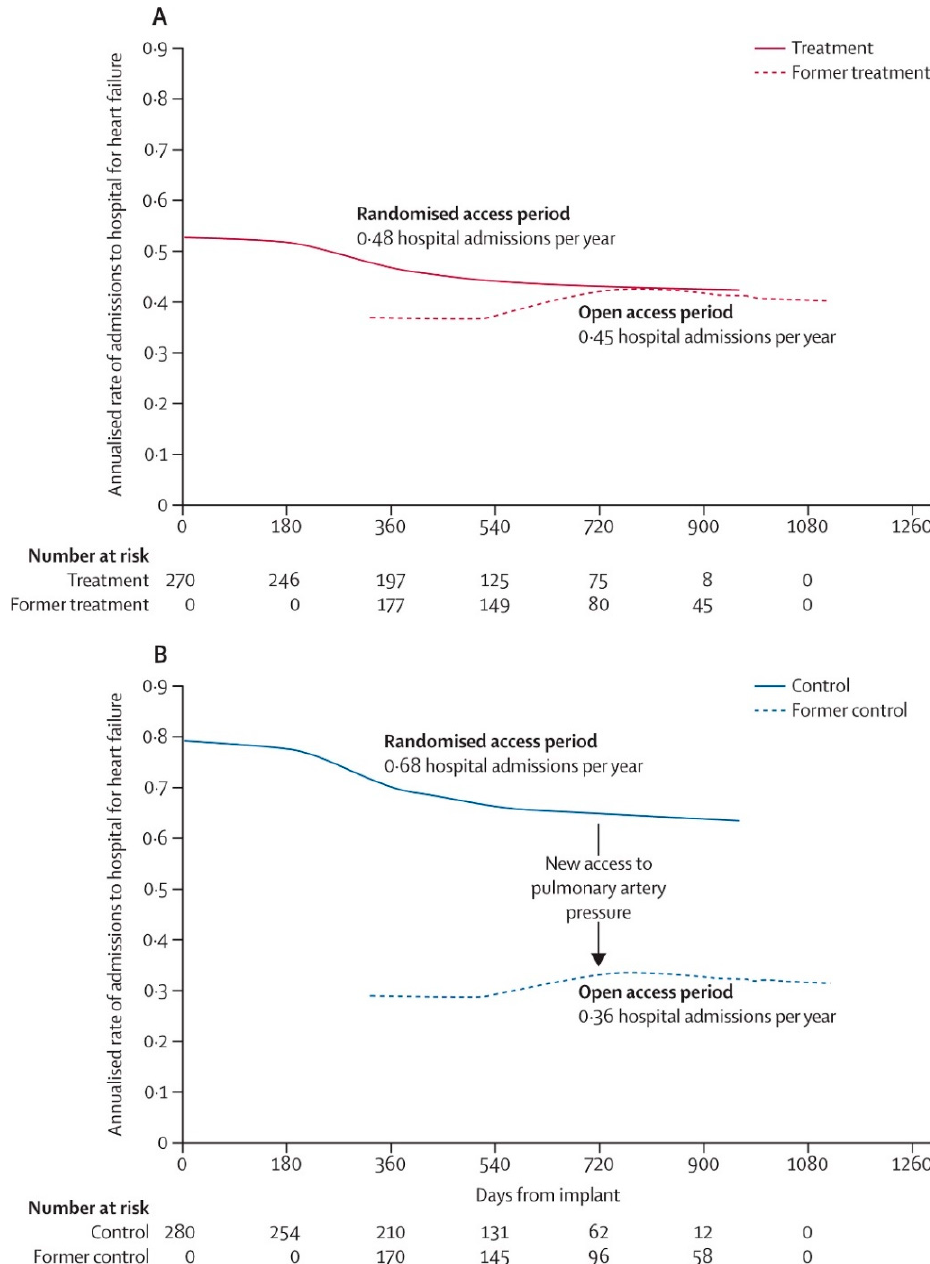
Figure 3. Long-term results from the CHAMPION trial: Effect of continued access to pulmonary artery pressure information on the change in rates of admission to hospital for heart failure during open access in the former treatment group ( A ) and on the change in rates of admission to hospital for heart failure during open access and in the former control group ( B ). Reprinted from The Lancet, Volume 387, Issue 10017, Abraham et al., Sustained efficacy of pulmonary artery pressure to guide adjustment of chronic heart failure therapy: complete follow-up results from the CHAMPION randomized trial, pages 453–461, Copyright 2016, with permission from Elsevier [5].